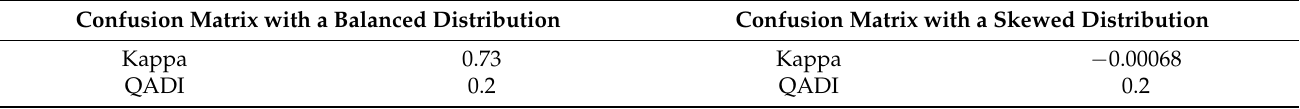
Table 11. Comparison of QADI and Kappa values for a balanced distribution and a skewed